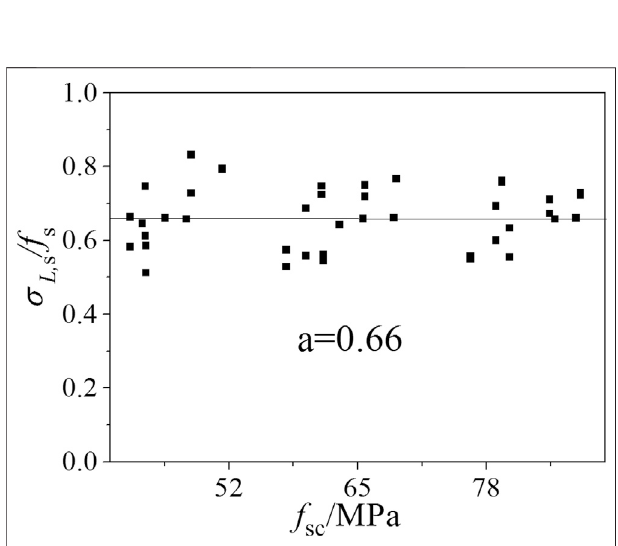
FIGURE 13 | Average ratios of axial compressive stresses to yield stresses of the steel